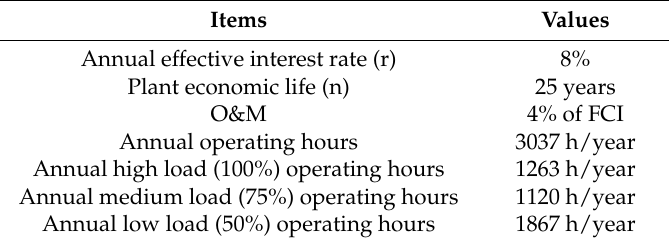
Table 5. Basic parameters for economic analysis.